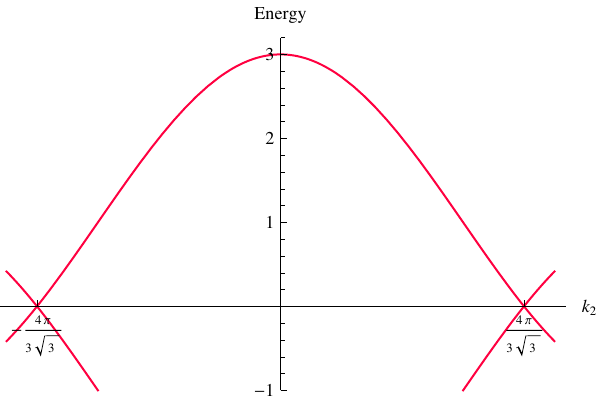
= 0 with two Dirac cones at the 1